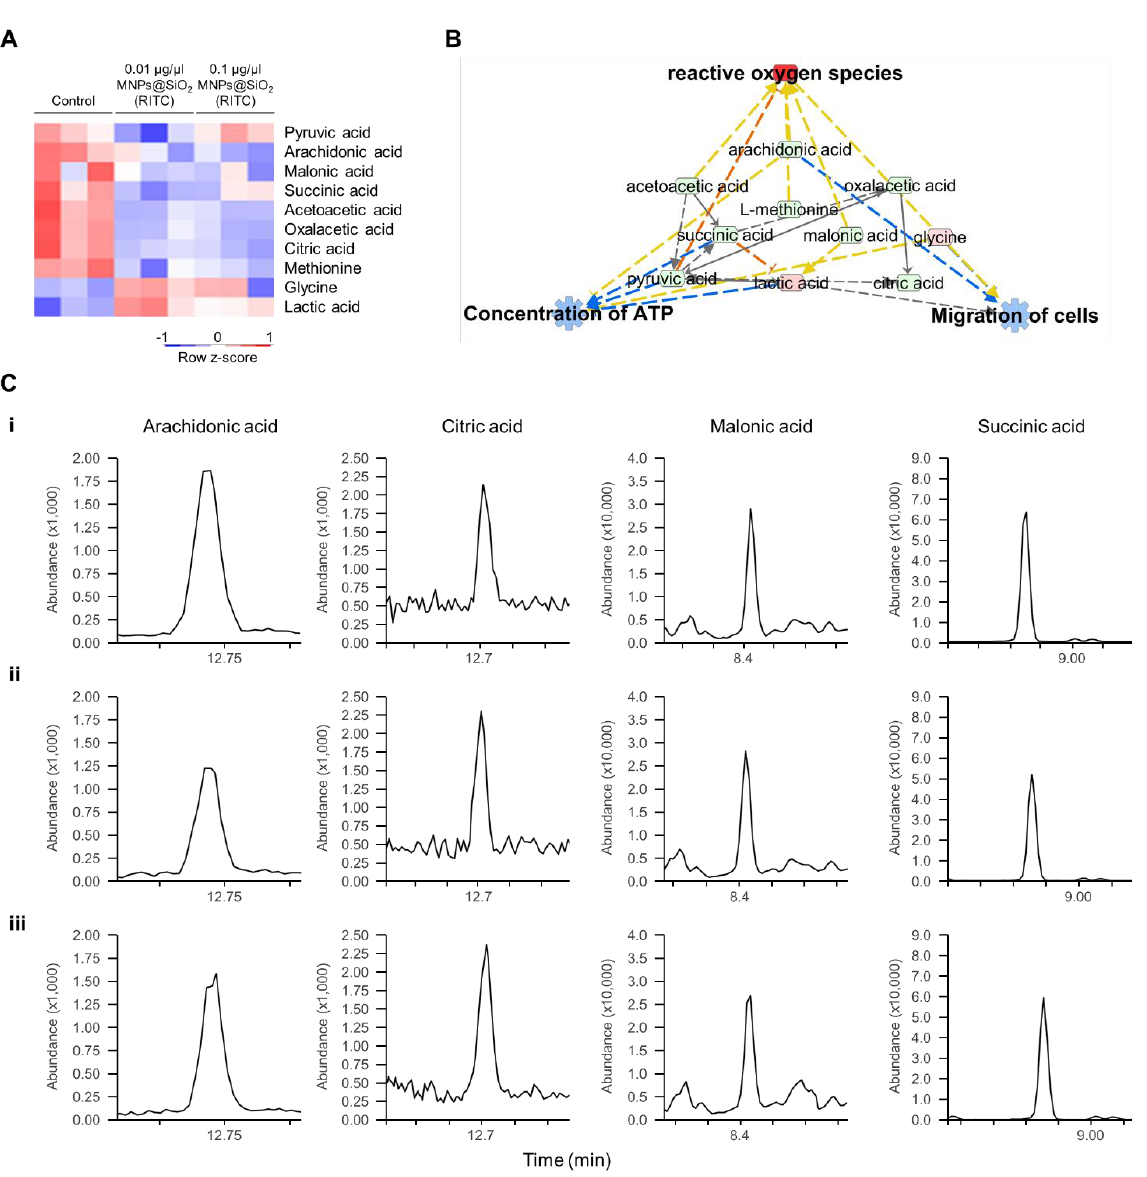
Figure 4. Metabolic profiling of MNPs@SiO 2 (RITC)-treated BV2 cells. ( A ) Heatmap of nine metabo- lites related to the cellular movement in the metabolome of MNPs@SiO 2 (RITC)-treated BV2 cells as observed with GC – MS/MS analyses. ( B ) Functional analysis of the metabolomic network in 0.1 μg/μL MNPs@SiO 2 (RITC)-treated BV2 cells with prediction using IPA. The analysis involved a fold change cut-off value of ±1.2. Red and green nodes indicate genes whose expressions were upregu- lated and downregulated, respectively, compared to those of the control. Orange and blue arrows indicate the prediction of activation and inhibition, respectively. Details of the shape and colour, which are originated from IPA. ( C ) Representative selected-ion monitoring chromatograms of ara- chidonic acid, citric acid, malonic acid, and succinic acid for ( i ) control, ( ii ) 0.01, and ( iii ) 0.1 µg/µL MNPs@SiO 2 (RITC)-treated BV2 cells.